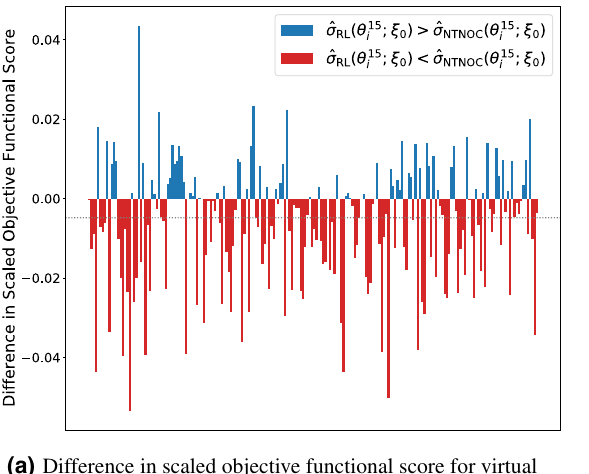
(a) Difference in scaled objective functional score for virtual patients at 15% perturbation strength.